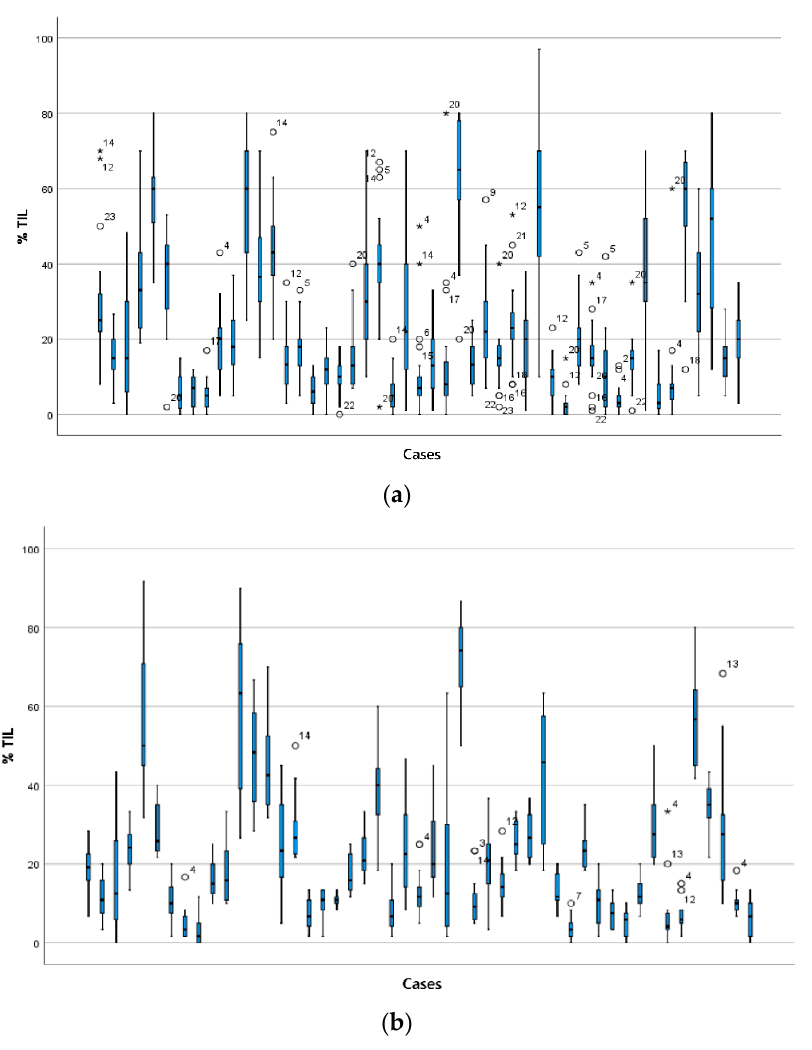
Figure 3. sTILs scores for TNBCs. The range of sTILs scores is shown for the 49 cases in ( a ) circulation